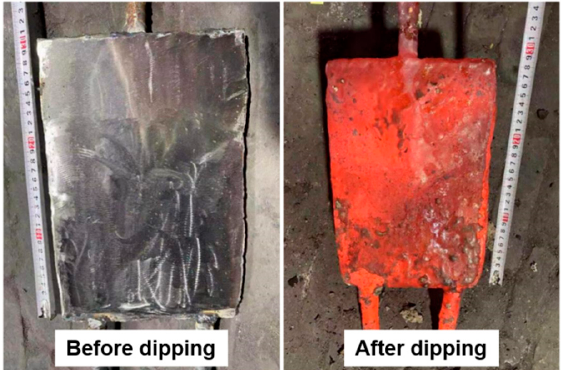
Figure 3. Sampler before and after dipping into liquid steel.